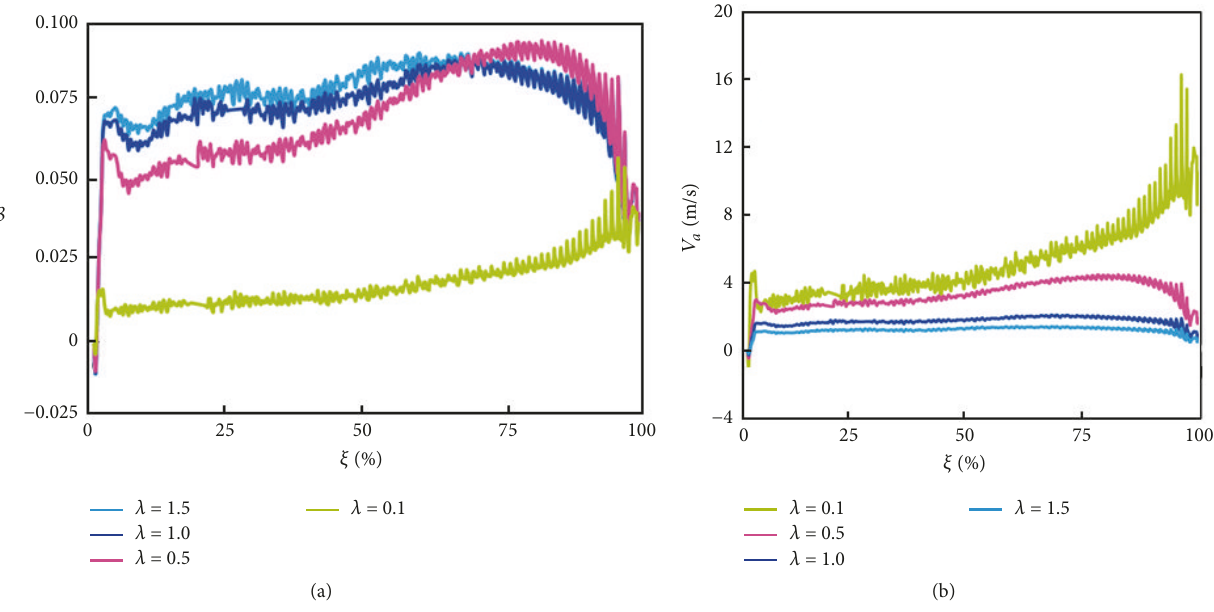
Figure 8: Change of 𝛽 and 𝑉 𝑎 with 𝜉 at 𝜆 = 0.1, 0.5, 1.0, and 1.5.